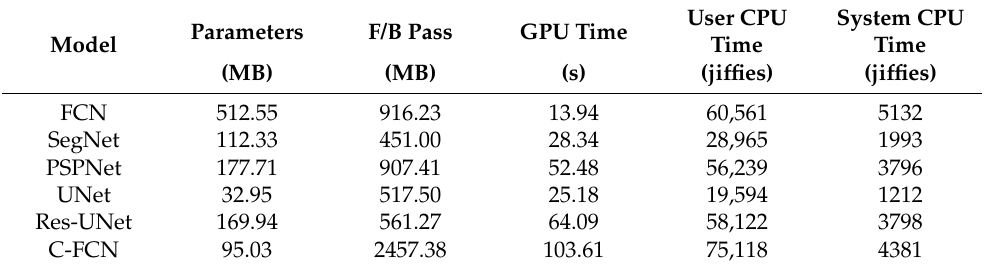
Table 6. Comparison results of parameter sizes and inference time on Vaihingen test